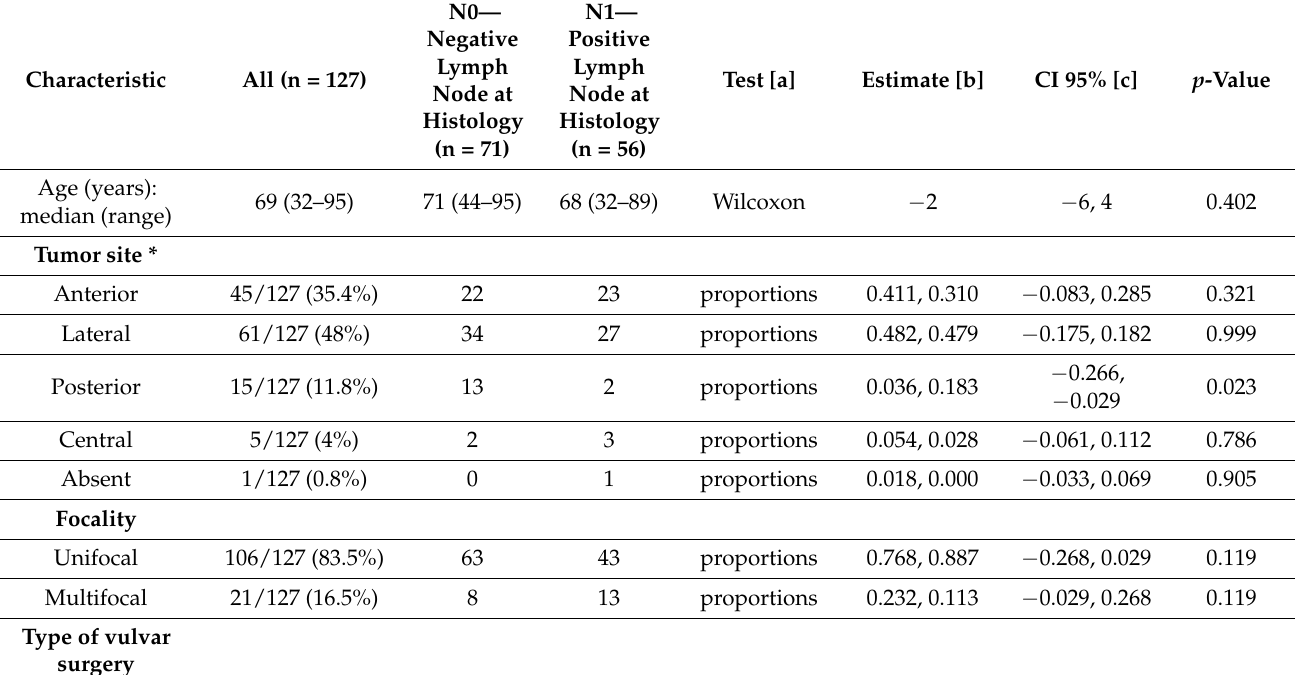
Table 1. Clinical, surgical, histopathologic and ultrasound